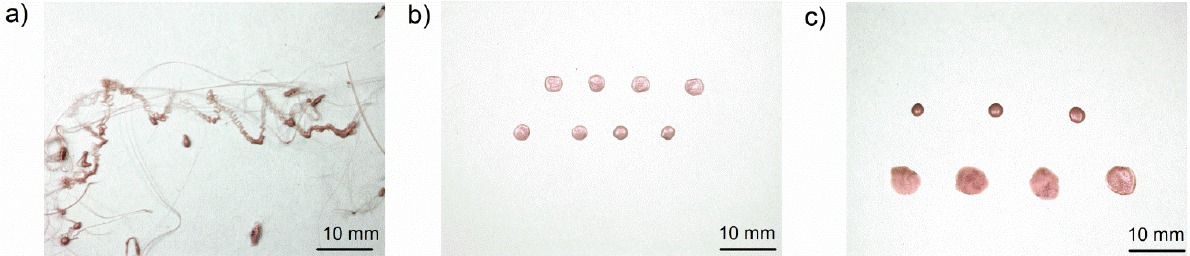
Figure 6. ( a ) Melt flow and dripping of PP-EP HB at a furnace temperature of 450 °C; ( b ) drops of PP-EP V-2 at 500 C; and ( c ) drops of PP-EP V-2 at 600 °C.